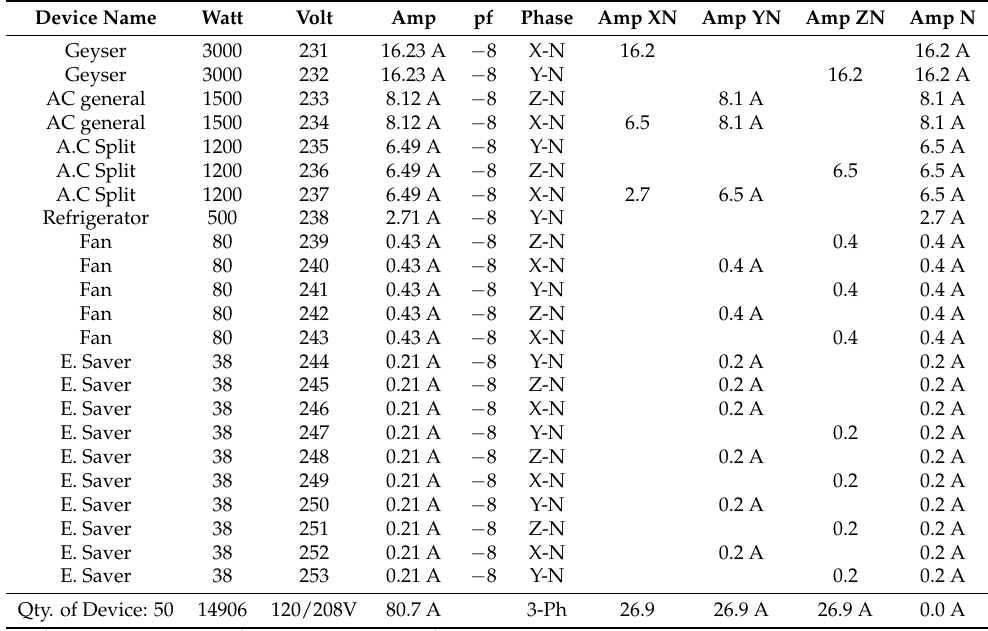
Table 15. Coordinator House proposed load data.